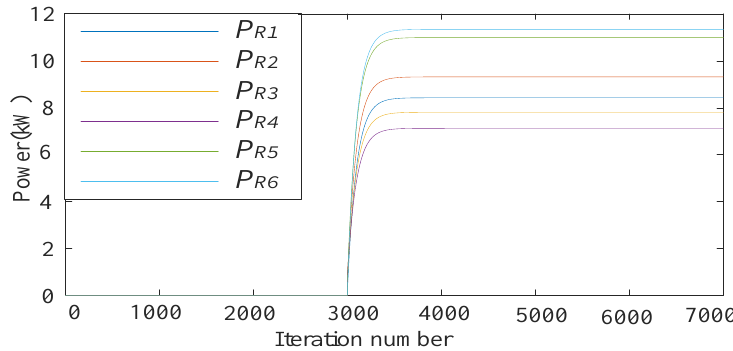
Figure 6. The power of each customer with neighbor interconnection.